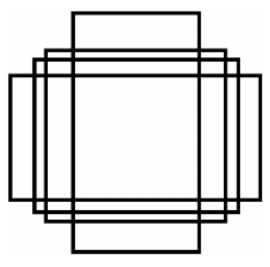
Figure 5. The new anchor ratios.